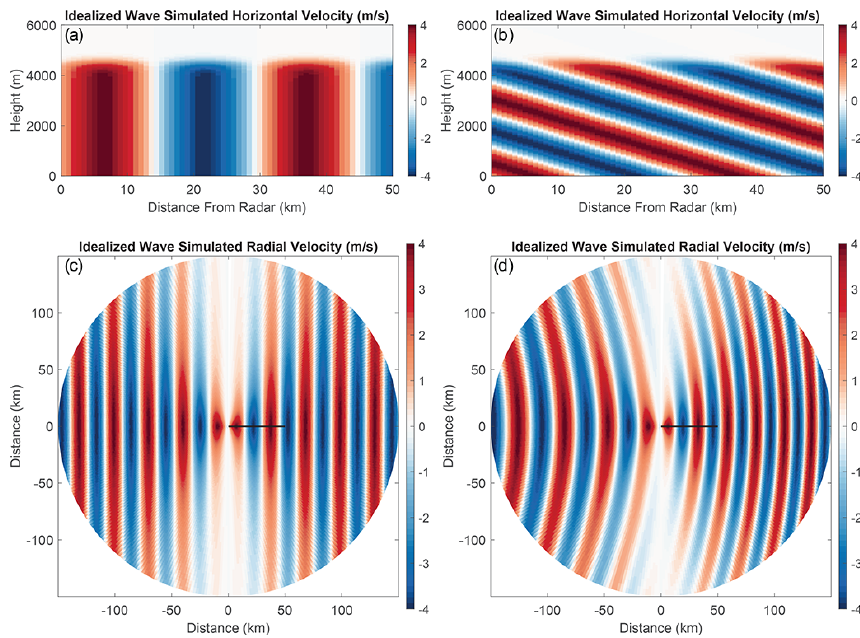
Figure 3. Cross sections and simulated radial velocity images of vertical and tilted idealized velocity waves. Both sets of velocity waves have a wavelength of 30.7km, a depth of 4500m, and a maximum horizontal velocity perturbation of 4ms − 1 . The waves in (a) and (c) are upright and the waves in (b) and (d) are tilted. Panels (a) and (b) depict vertical cross sections of the horizontal (zonal) velocity perturbations. Panels (c) and (d) simulate radial velocity observations as would be seen by a NWS WSR-88D precipitation radar with a PPI beam elevation of 0.5 ◦ , a maximum range of 150km, a 0.95 ◦ beamwidth, and 500m range gates. The solid black lines denote the span of the cross sections shown in (a) and (b) . The vertical and tilted waves have the same cross-band widths. Panels (a) and (b) use a 1:3.8 z -axis to x -axis aspect ratio. An animated version of this figure is in Video Supplement